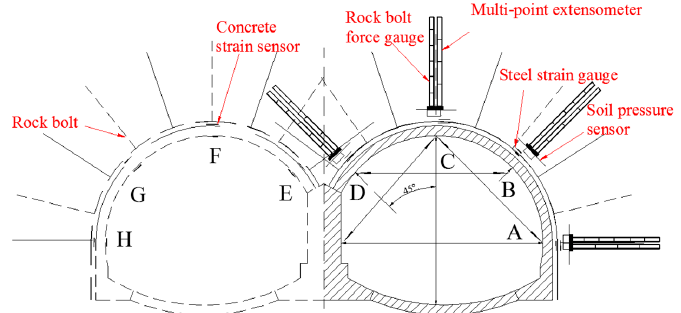
Figure 8. Layout diagram of the measuring points in class IV and V surrounding rocks (K90+105, K89+729 respectively).